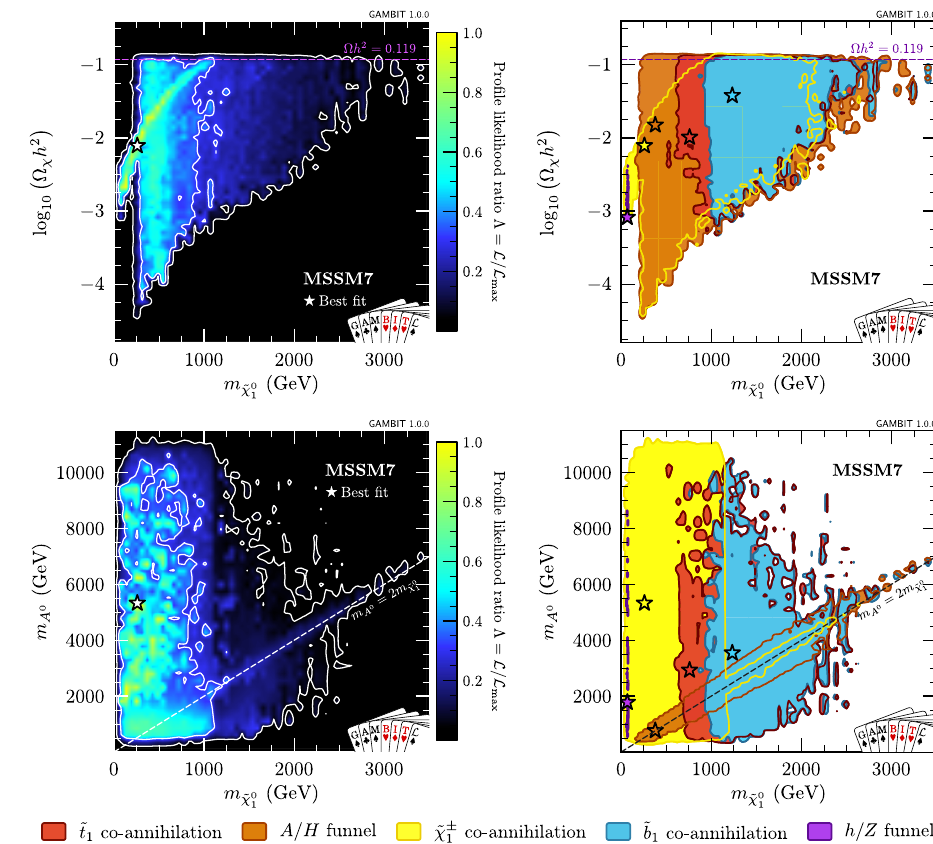
Fig. 4 Left: joint profile likelihoods in the mass of the lightest neutralino and its relic density (cid:12) h 2 (top), and in the masses of the lightest neutralino and the CP-odd Higgs A 0 (bottom). Right: coloured regions indicating in which parts of the 2 σ best-fit region different co-annihilation and funnel mechanisms contribute to the relic density. The best-fit point in each region is indicated by a star with the corresponding